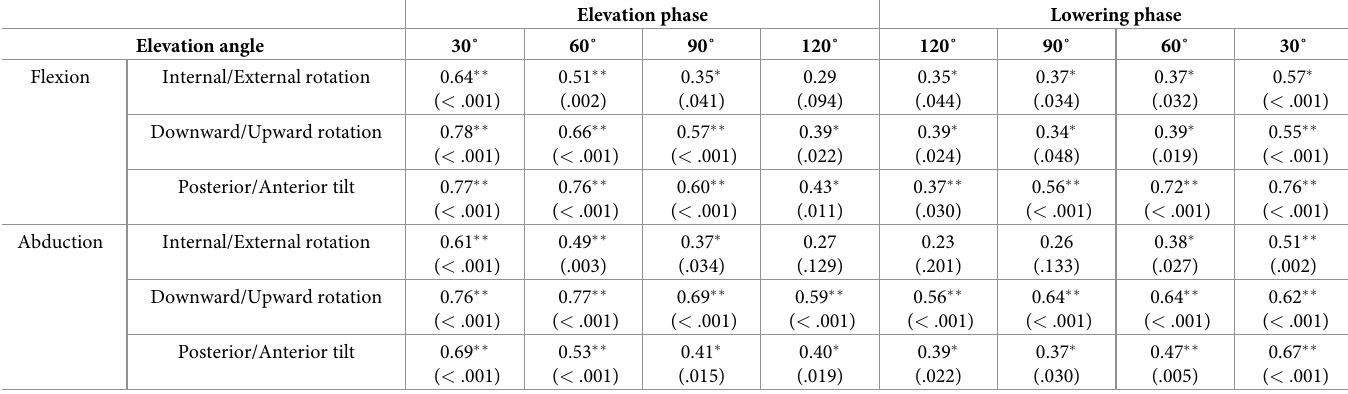
Table 3. Correlation coefficient between scapular initial position and scapular movement. Elevation phase Lowering